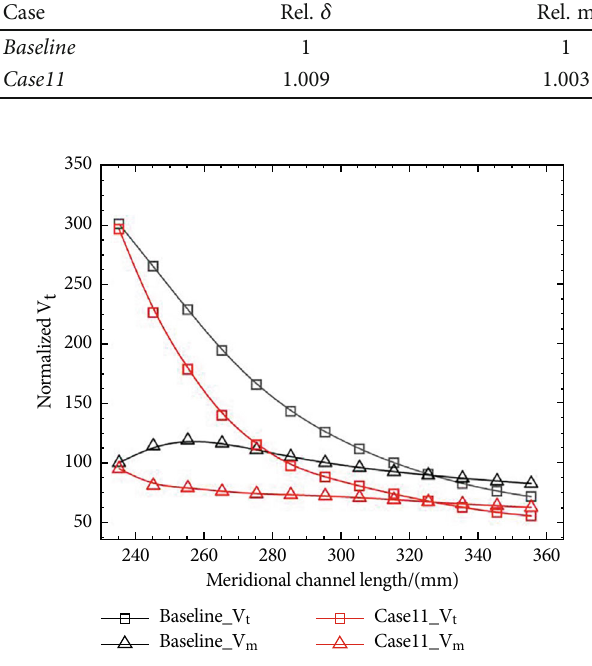
Figure 12: Velocity distributions of baseline and